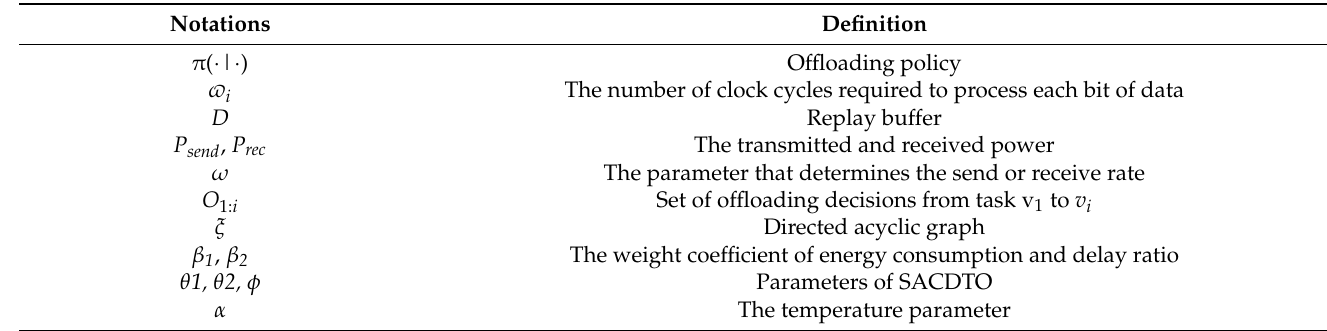
Table 2. Mathematical